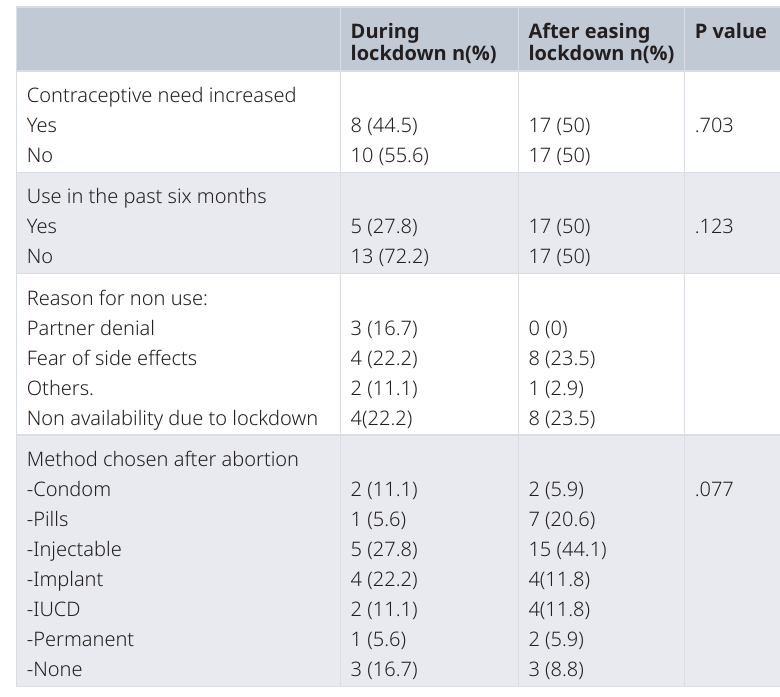
Table 3. Contraception use before during and after the lockdown period.